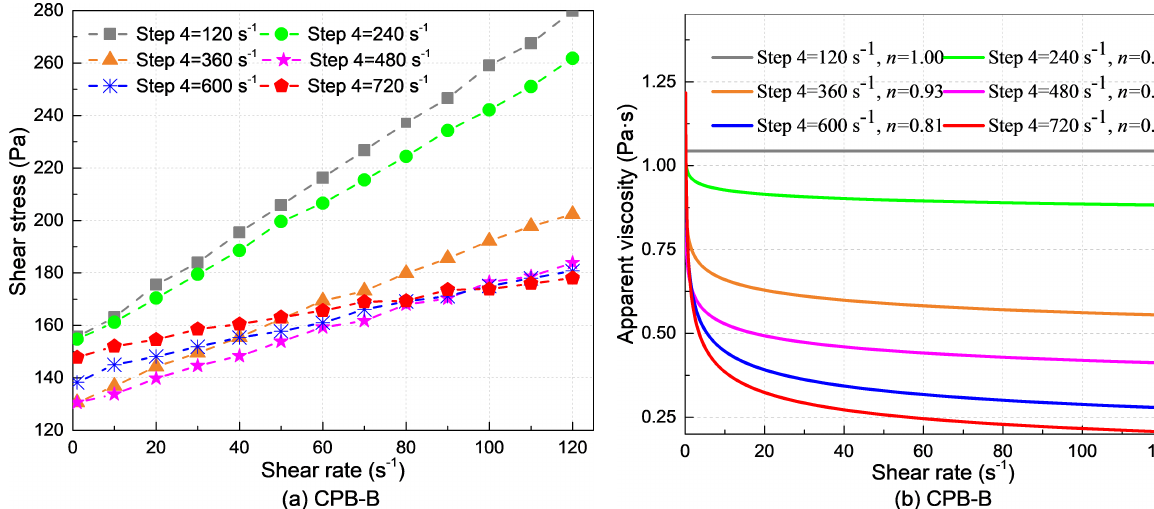
Figure 7: Effect of shear on flow curve behavior of CPB-B.